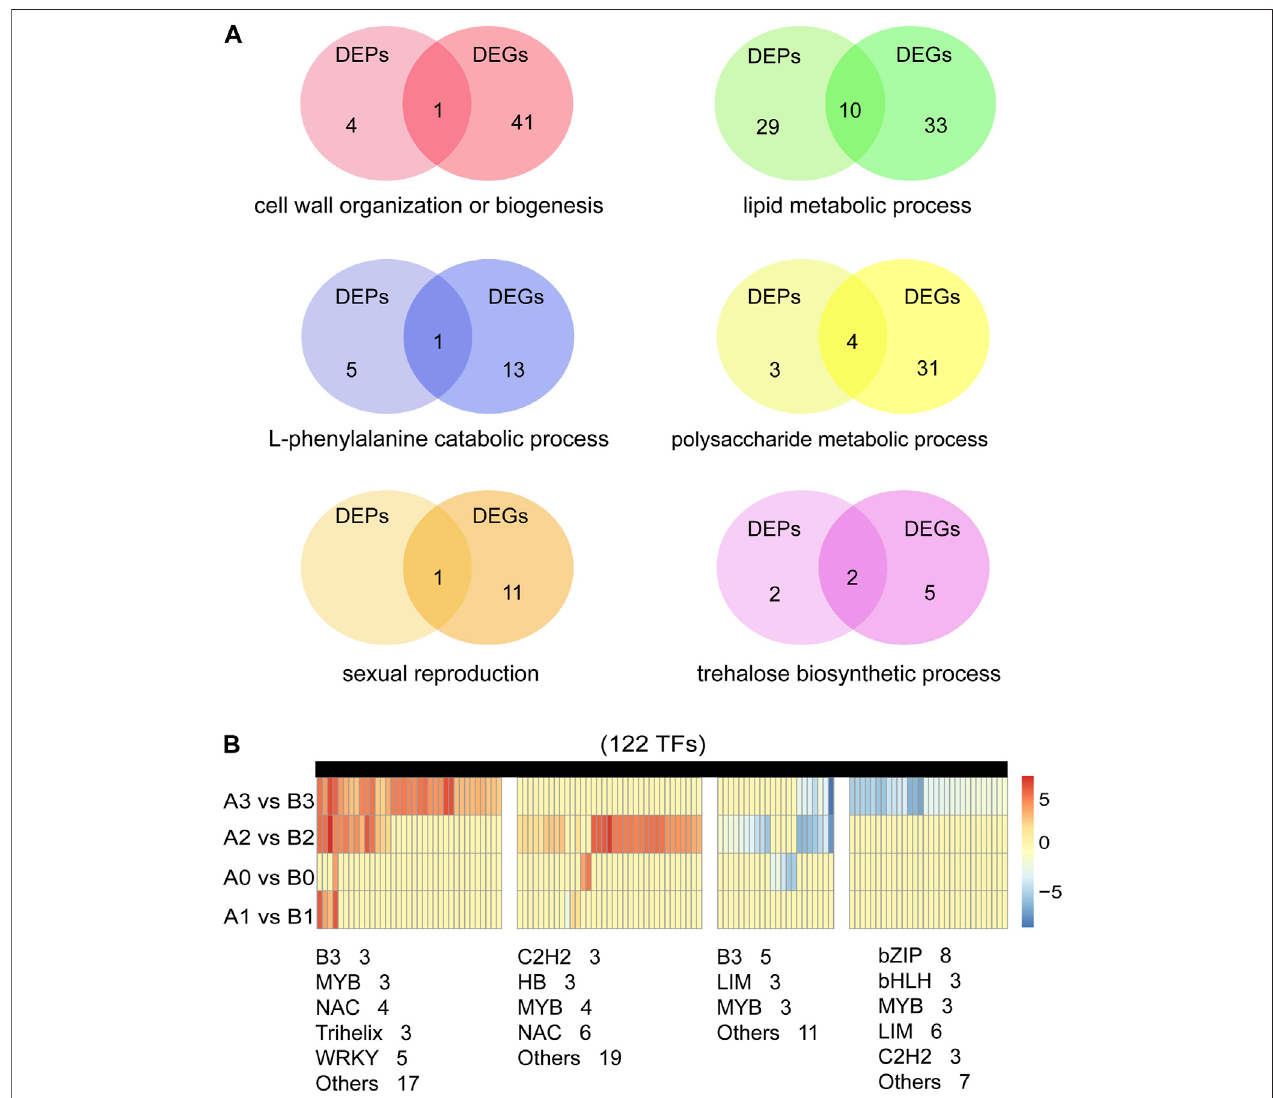
FIGURE 7 | Screening of genes related to anthers development. (A) Identi fi ed of DEPs and DEGs in six important biological processes of anther development. (B) Expression analysis of 122 transcription factors in DEGs.